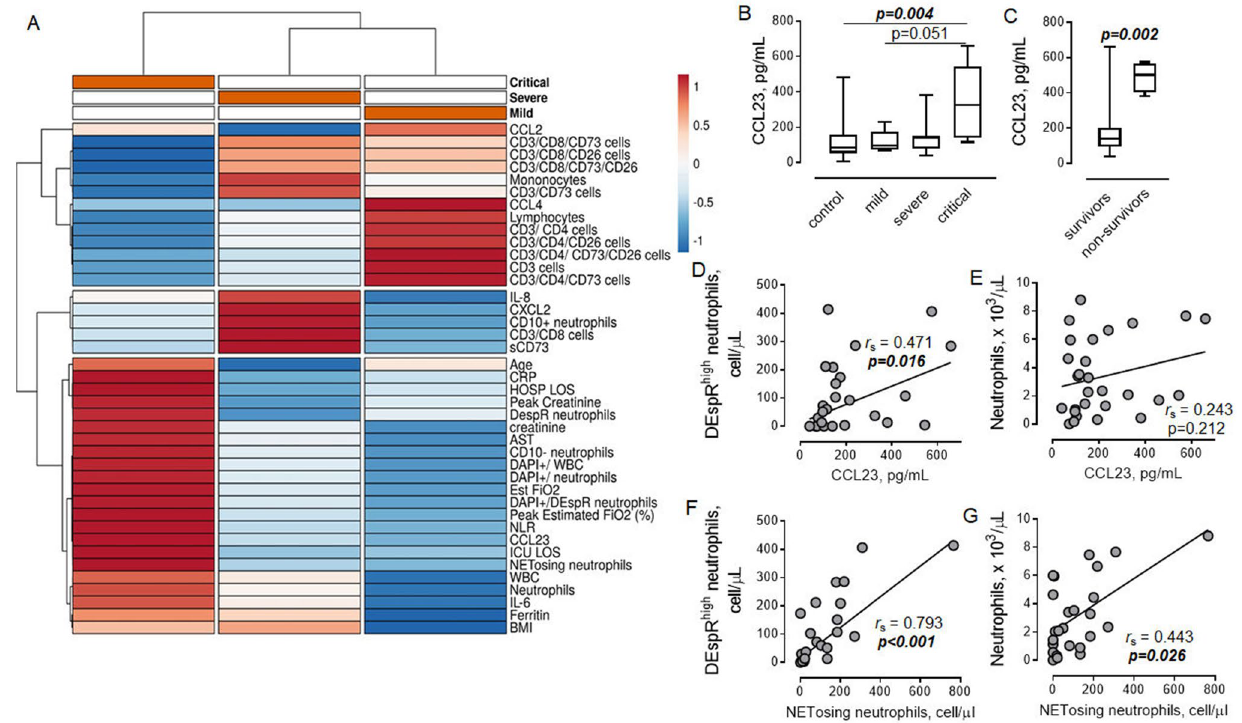
Figure 5. Association between DEspR high neutrophils and CCL23. ( A ) Heat map associated with hierarchical clustering analysis of tested parameters in groups of mild ( n = 6), severe ( n = 9), and critical ( n = 10) COVID- 19 patients obtained using ClustVis 2.0. Columns with similar annotations are collapsed by taking the median inside each group. Rows are centered; unit variance scaling is applied to rows. Both rows and columns are clustered using correlation distance and average linkage. Color keys show the relative strength of the signal in each cluster group. Annotations on top of the heatmap show clustering of the samples. AST aspartate aminotransferase, BMI body mass index, CRP C-reactive protein, DAPI + 4 ′ ,6-diamidino-2-phenylindole viability dye positive dead cells, Est FiO2 estimated fraction of inspired oxygen, HOSP LOS hospital length of stay, ICU LOS intensive care unit length of stay, sCD73 soluble CD73. ( B ) Association between the level of circulating CCL23 and COVID-19 severity. Spearman correlation coefficient and P value are indicated. ( C ) The level of CCL23 in COVID-19 survivors ( n = 21) and non-survivors ( n = 4). Mann–Whitney test. ( D,E ) Associations between the level of CCL23 and number of ( D ) DEspR high neutrophils and ( E ) total neutrophils in COVID-19 patients. ( F,G ) Relationships between the number of NETosing neutrophils and number of ( F ) DEspR high neutrophils and ( G ) total neutrophils in COVID-19 patients. ( D–G ) Spearman correlation coefficients and P values are